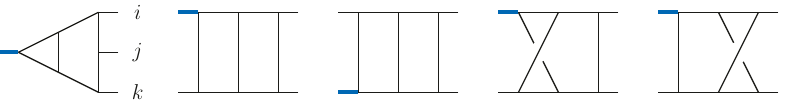
Figure 7. Integral topologies of maximal number of propagators for the two-loop three-point form